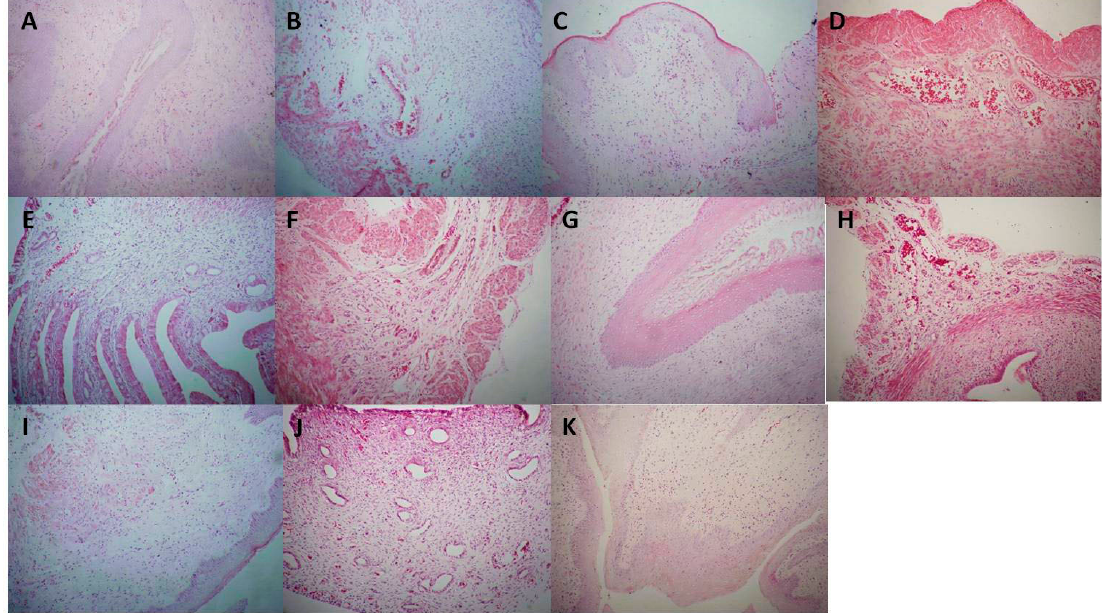
Figure 5. Histopathological changes in the cervixes of SD rats treated with different extracts obtained from C. nudiflora . ( A ) Control group. ( B ) Model group. ( C ) XMS-treated group. ( D ) CNEH-treated group. ( E ) CNEL-treated group. ( F ) CNE-p H-treated group. ( G ) CNE-pL -treated group. ( H ) CNE-dH-treated group. ( I ) CNE-dL-treated group. ( J ) CNE-bH-treated group. ( K ) CNE-bL-treated